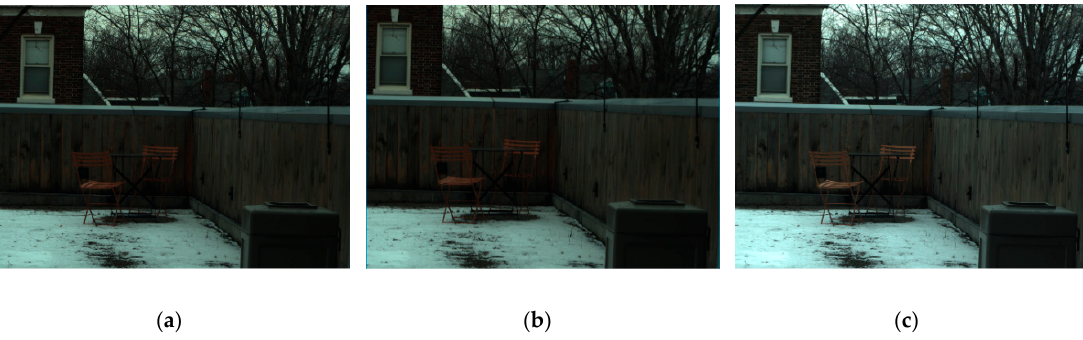
Figure 2. Example of pixel mismatch environment created by image processing: ( a ) Original RGB image reconstructed from an HSI from the Harvard dataset [34] with camera sensitivity for a Nikon D700, ( b ) mismatched image where 50 pixels on the upper and left sides are cut off; ( c ) color mismatched RGB image reconstructed using a Nokia N900.